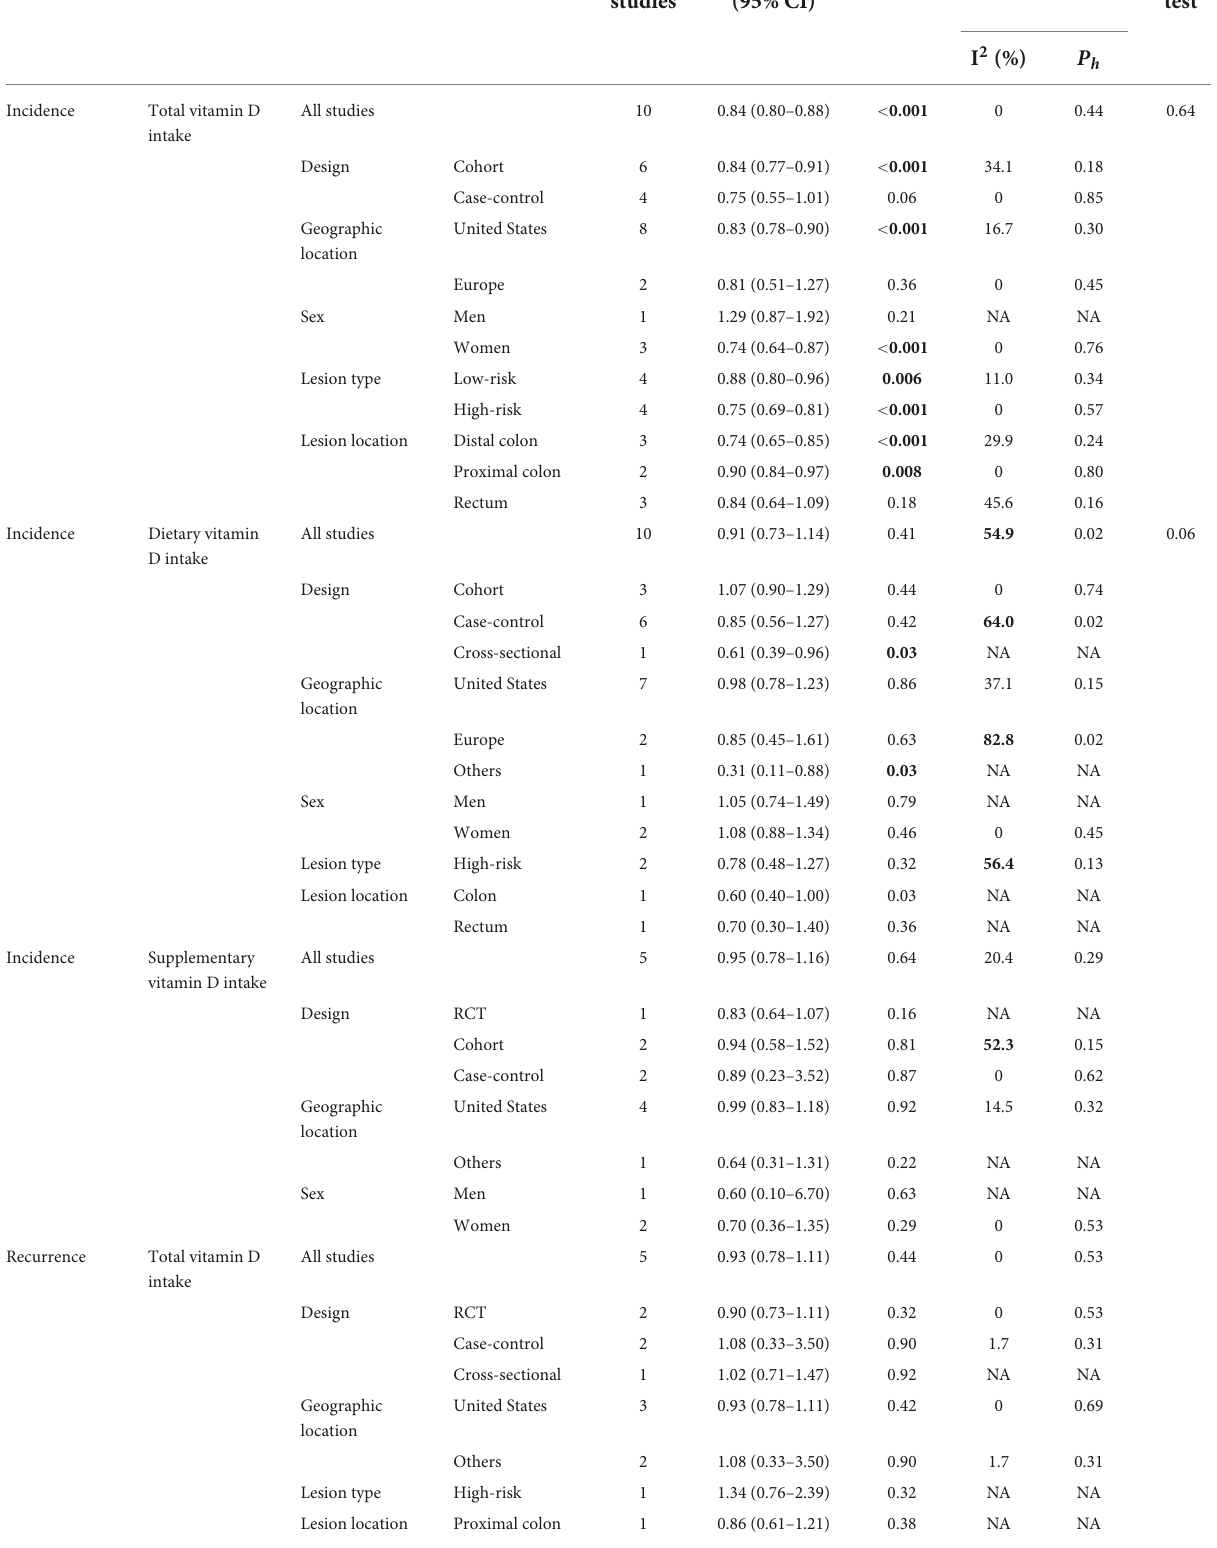
TABLE 1 Summary of